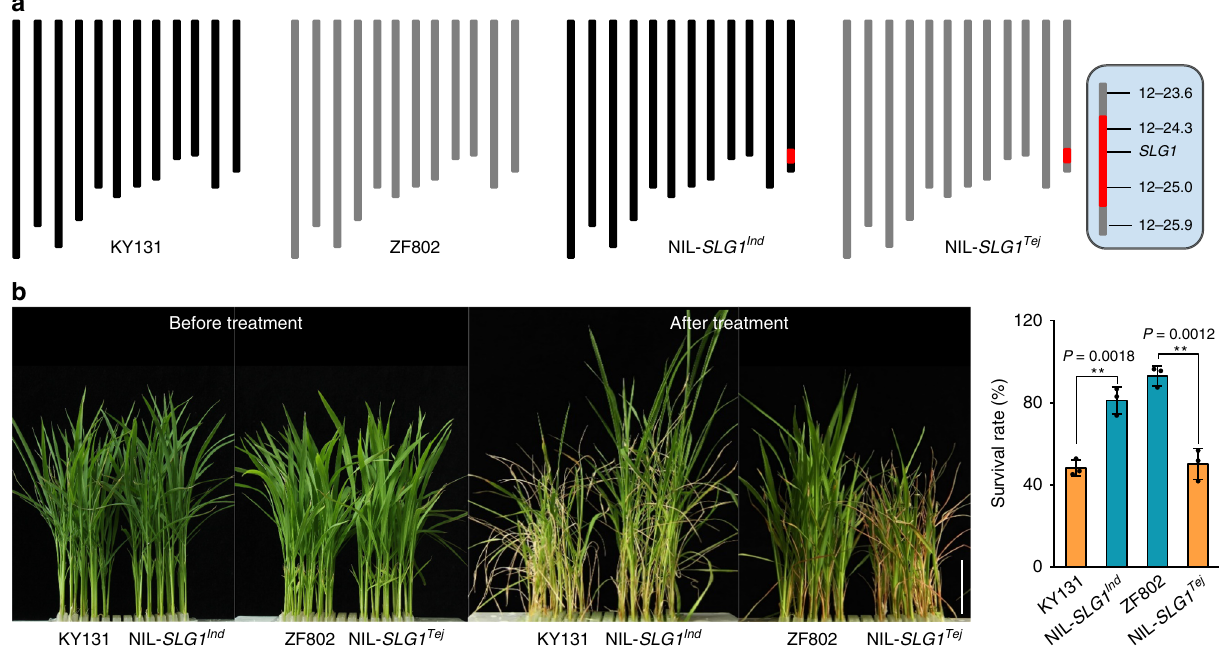
Fig. 4 SLG1 Ind confers higher thermotolerance than SLG1 Tej . a Chromosome maps of NIL- SLG1 Ind and NIL- SLG1 Tej . Red rectangles indicate the donor segment containing the SLG1 locus. NIL- SLG1 Ind indicates KY131 ( temperate japonica ) with SLG1 Ind allele from ZF802 ( indica ), and NIL- SLG1 Tej indicates ZF802 with SLG1 Tej allele from KY131. b Comparison of thermotolerance between SLG1 Ind and SLG1 Tej alleles. Two-leaf-stage seedlings were treated with 45 °C for 56 h for KY131 and NIL- SLG1 Ind , and 64 h for ZF802 and NIL- SLG1 Tej , respectively. The seedlings were then recovered under normal conditions for 10 days. Data are means ± SD ( n = 3 biological replicates, with 80 – 96 seedlings per biological replicate). ** P < 0.01, two-tailed Student ’ s t -test. Bar = 5 cm. The source data underlying ( b ) are provided as a Source data fi